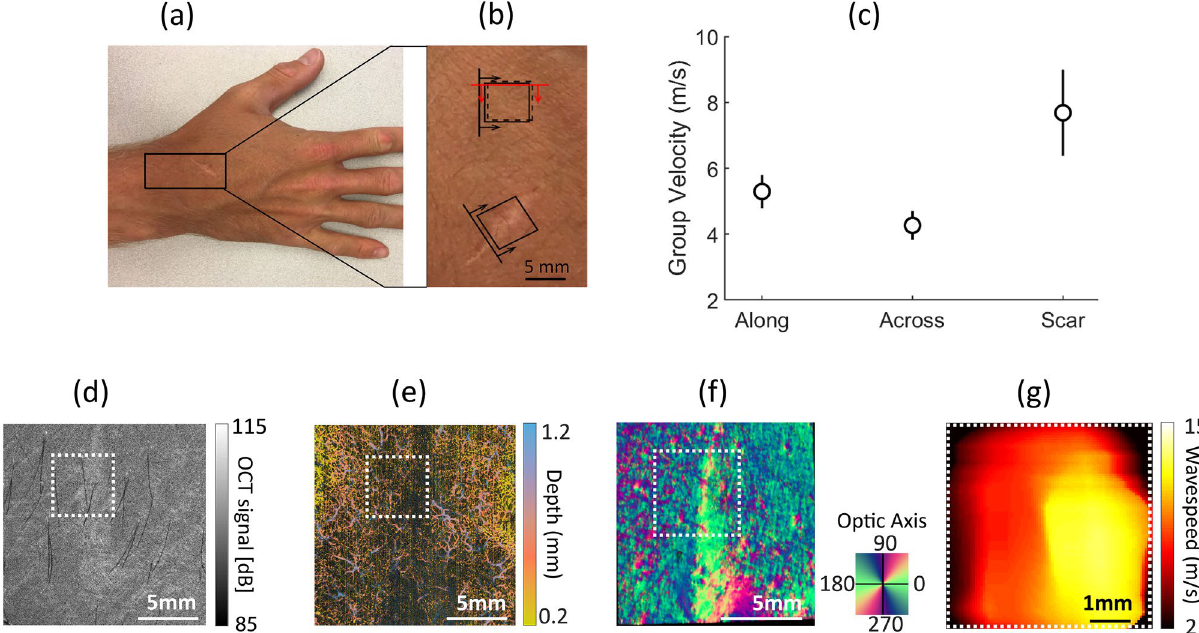
Figure 5. Characterization of scar tissue in vivo with four different OCT modalities. ( a ) Photograph of the scar area in a 28-year-old male volunteer. ( b ) Its enlarged area with the direction of mechanical wave propagation in the scar and adjacent skin site. ( c ) Group velocity of Rayleigh wave in scar and in normal skin tissue in two orthogonal directions. Structural OCT ( d ) and OCT angiography ( e ) images obtained with the system described in Ref. 72 . ( f ) Optic axis orientation map obtained with the PS-OCT system described in Ref. 68 . ( g ) Image of Rayleigh wave group velocity measured in the direction perpendicular to scar within the area covered by a white dashed rectangle (shown in panels ( d – f ) for scaling). The AμT-OCE image was obtained with the system described in Ref. 19,64,65